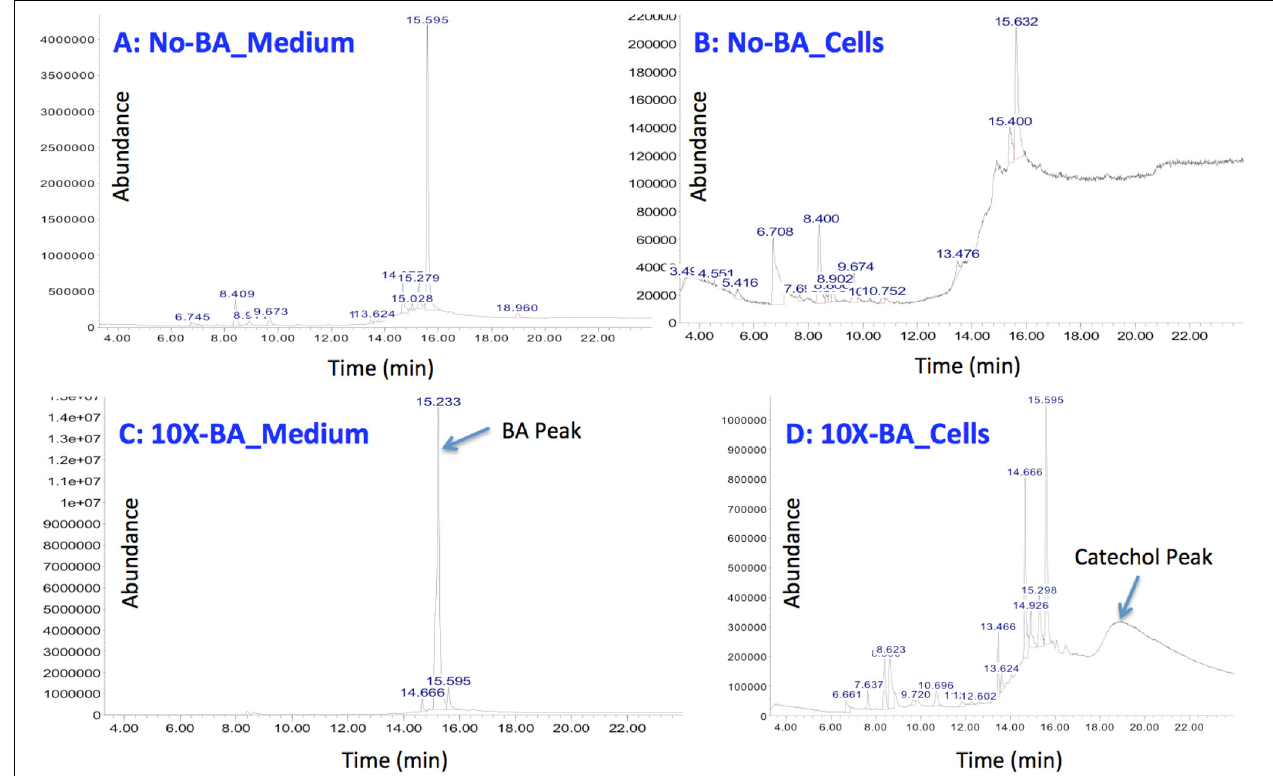
FIGURE 6 | GC-MS/MS result for supernatants from minimum medium only without benzoic acid supplementation (A), minimum medium only without benzoic acid supplementation but with C. necator inoculation